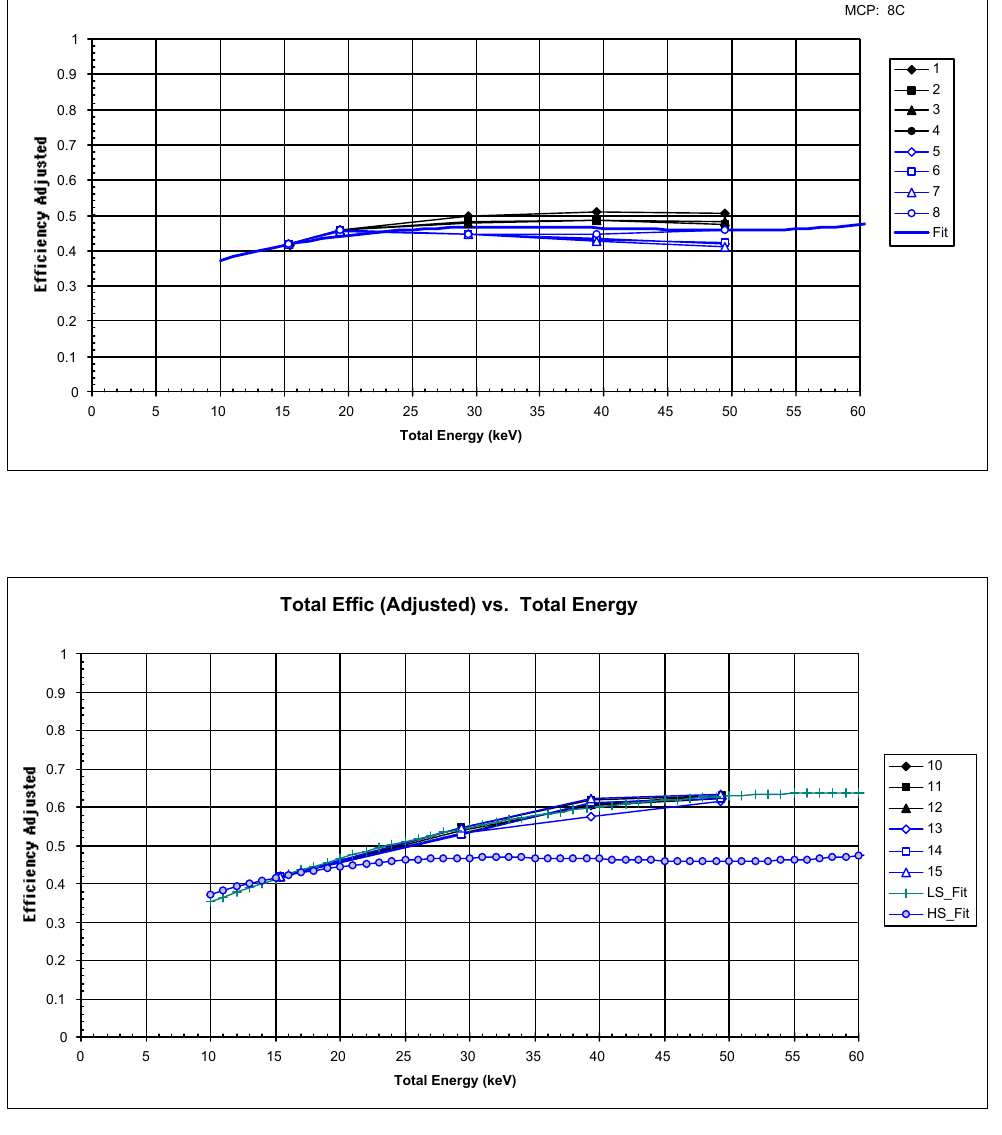
Fig. 13. CODIF FM7 High Side normalised total efficiency verses total energy for H + for the different anodes and with a general fit (upper curve) and CODIF FM7 Low Side normalised total efficiency verses total energy for H + for the different anodes and with a general fit; High Side fit of the upper curve is added (lower